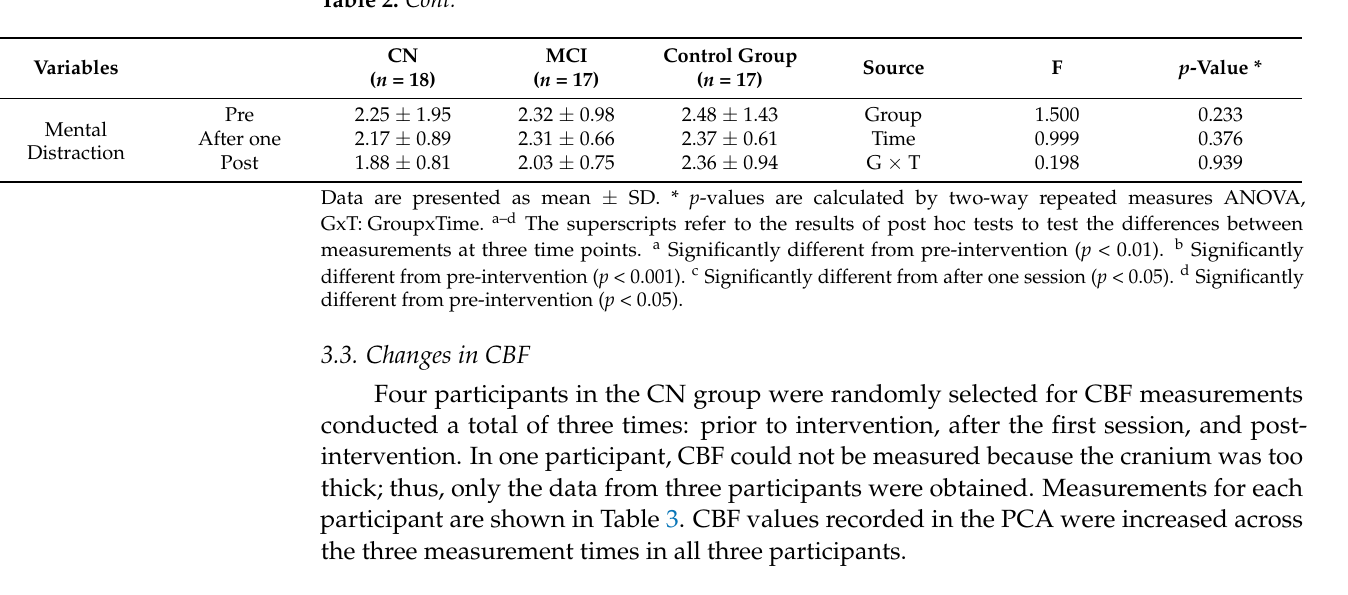
Table 3. Cerebral blood flow measurements of three participants in CN